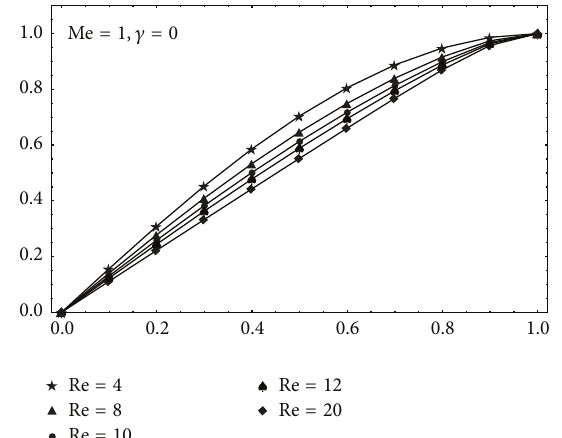
Figure 7: Velocity profile for different values of Reynold number with Me = 1 and 𝛾 = 0